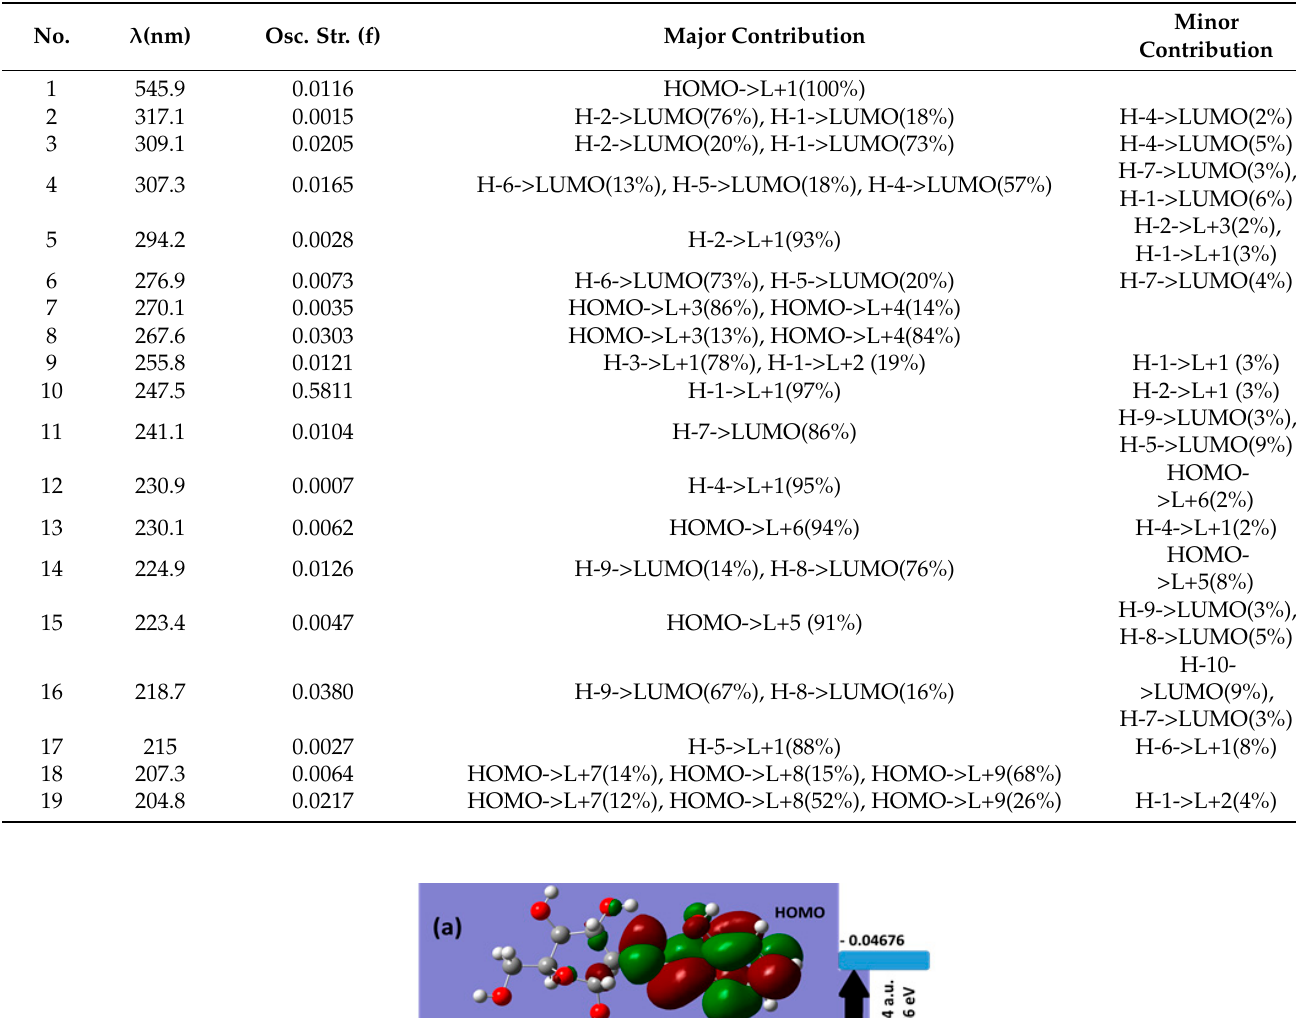
Table 5. TD-DFT data for GASB-1 in water.